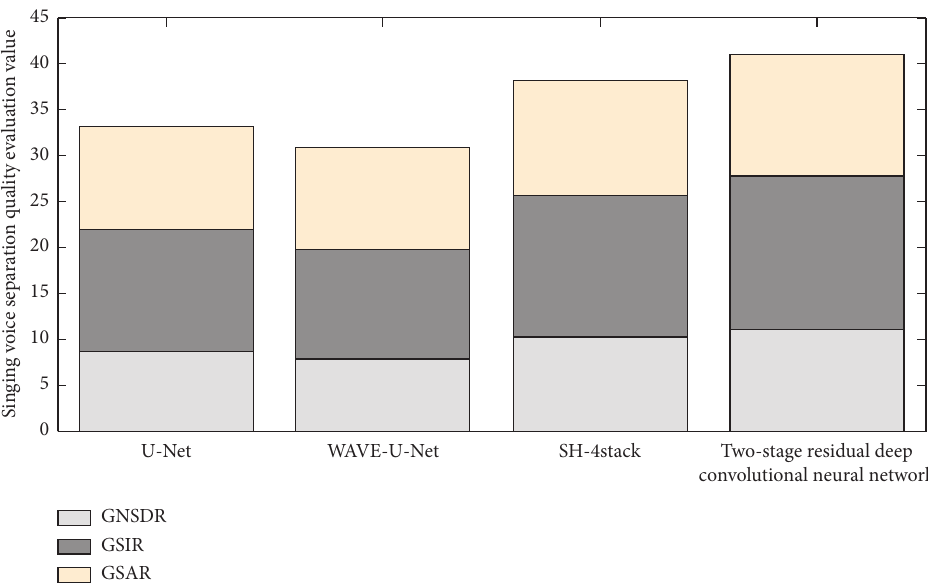
Figure 6: Overall assessment of singing voice separation quality.